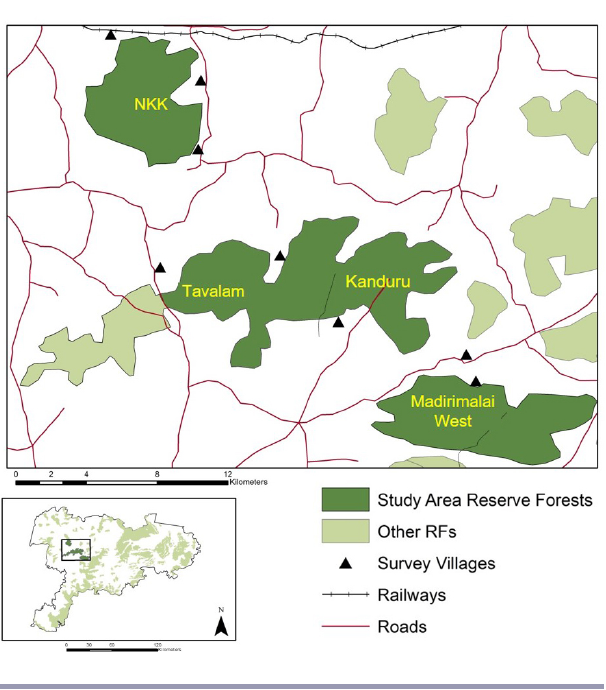
Fig. 2. Map showing the location of the study area Reserve Forests and villages in Chittoor District, Eastern Ghats,